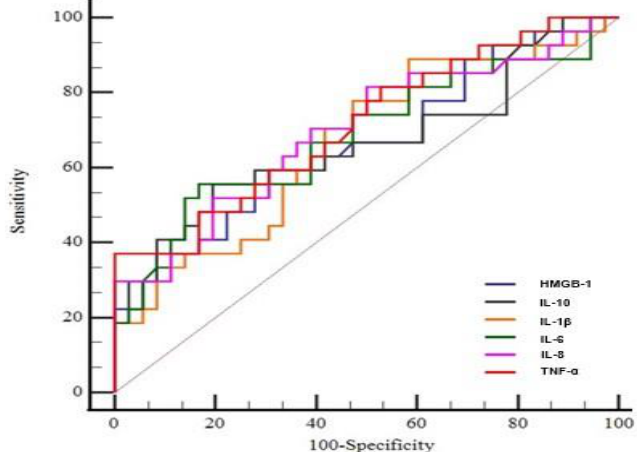
Figure 1. ROC analysis curve demonstrating the association of cytokines with mortality. Table 3. ROC analysis demonstrating cut-off values of cytokines associated with mortality. ratio: 7.081, p = 0.014) (Table 4). Table 4. Logistic regression analysis demonstrating the factors predicting